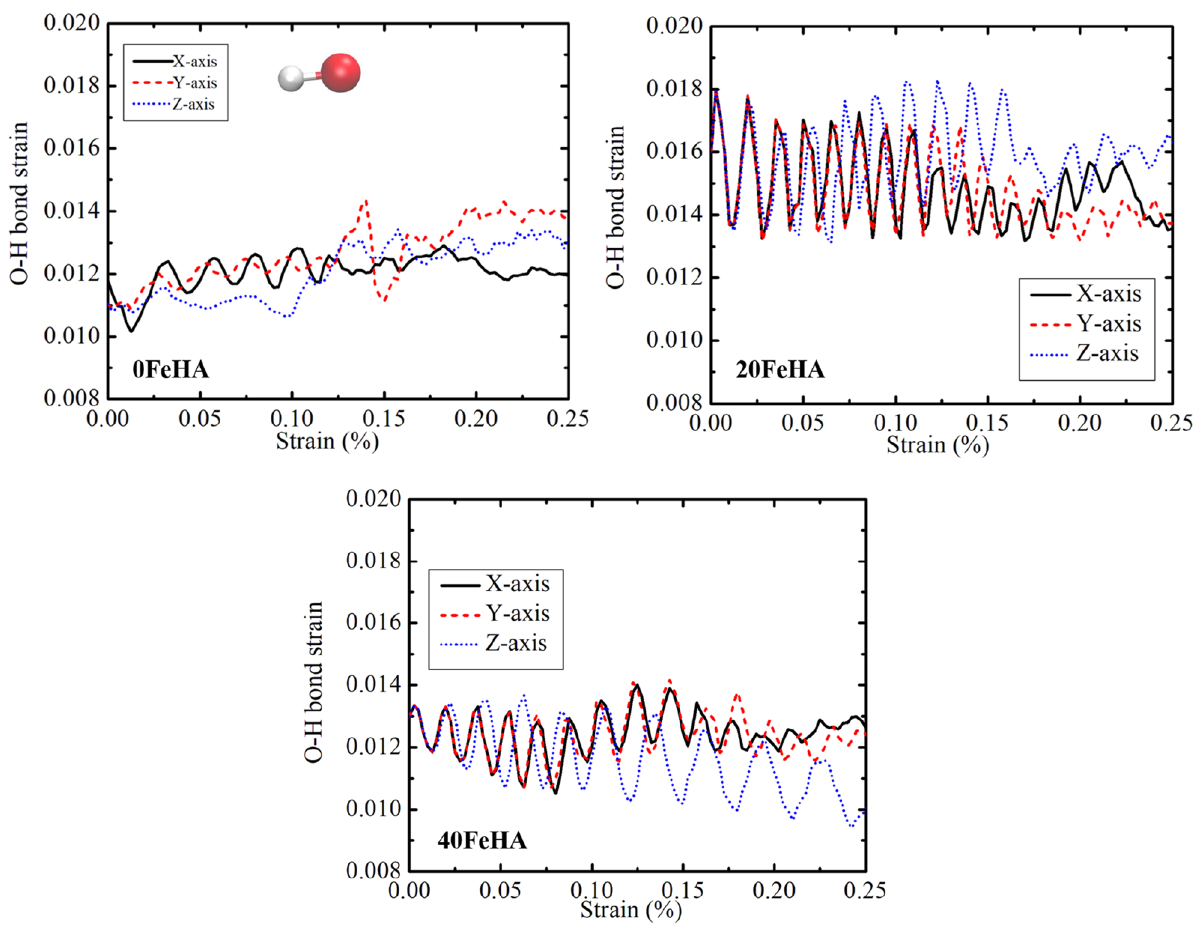
‘ c’ axis after doping. (b) The presence of Fe 2+ ions inside the doped HA lattice restricts the chemical symmetry around the functional groups and this corroborates well with the changes in the number and intensity of the calculated IR bands. (c) The tensile strength of HA decreases with Fe 2+ doping because of the changes in the atomic charge distri- bution inside the crystal structure. The elastic modulus of Fe-doped HA is comparable with the natural cortical bone. An increase in temperature induces higher bond vibration and thermal movement, which significantly decreases the tensile strength of HA. (d) The tensile deformation of Fe-doped HA at the atomistic level has been quantitatively analyzed using the dynamic changes in the major physical parameters of the covalent/ionic bond framework, including Ca–P distance, P–O bond strain, O–P–O angular strain, O–H bond distance with strain. Also, the temperature- dependent changes in tensile deformation have been analyzed by computing the dynamic changes in vibrational bond energy for O–H and P–O bonds. (e) No significant breakage of the covalent bonds in the apatite structure is recorded during the tensile defor- mation. O–H bond strain exhibited oscillatory nature under tensile load, in a manner dependent on Fe 2+ dopant content.